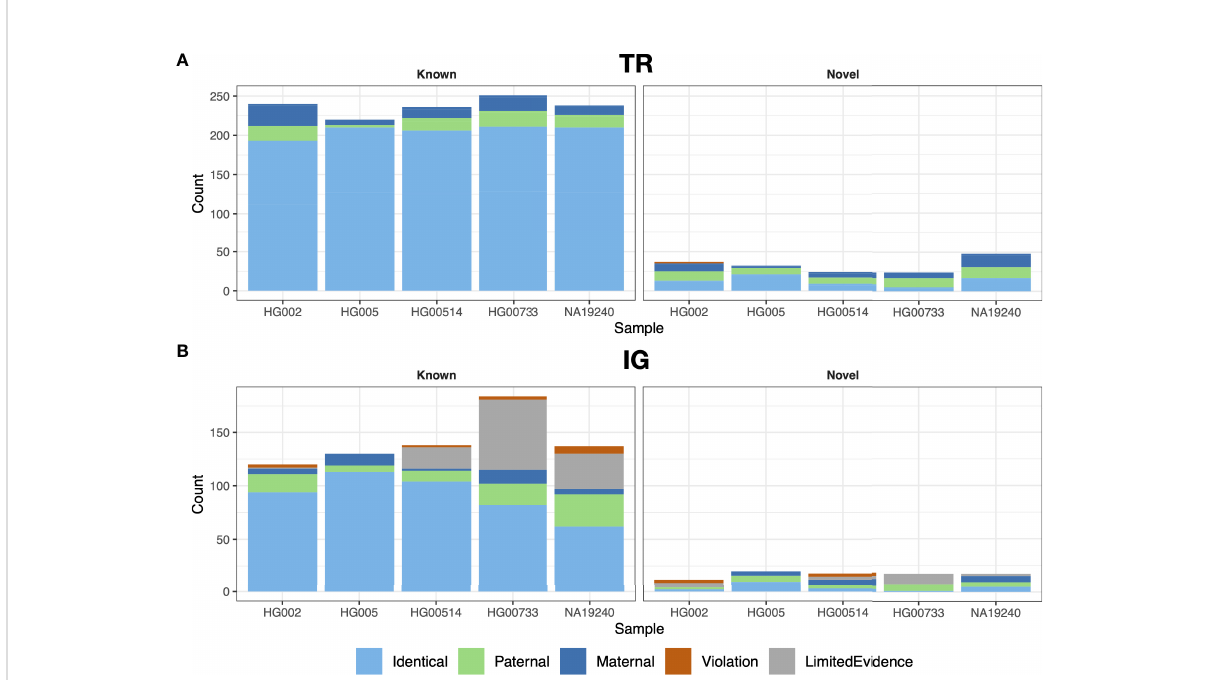
FIGURE 3 Trio validation for gAIRR-call and gAIRR-annotate. We validated gAIRR-call using the HG002 and HG005 families and validated gAIRR-annotate using the HG00514, HG00733, and NA19240 families. (A) TR loci, including all genes in TRV and TRJ. (B) IG loci, including functional IGV genes. The genes with V(D)J recombination evidence and genes without parental information due to gene lost are classi fi ed as